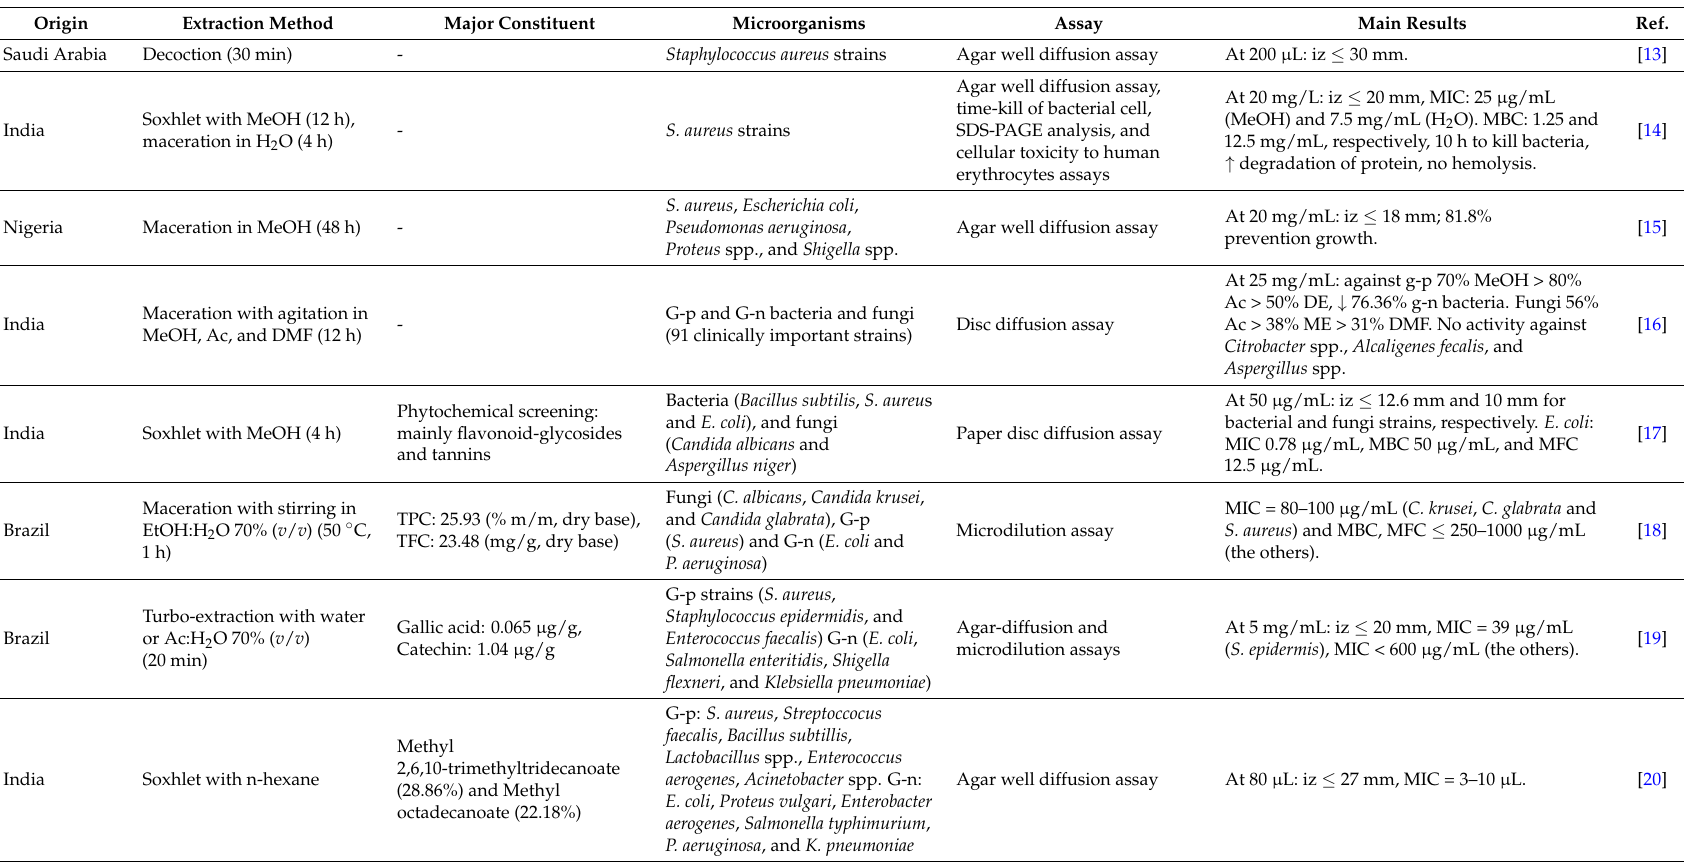
Table 1. In vitro assays against infectious and parasitic